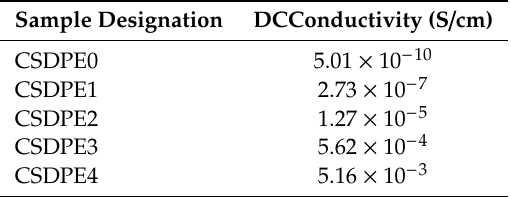
Table 1. Conductivity for pure CS: Ddextran and blended electrolyte films at room